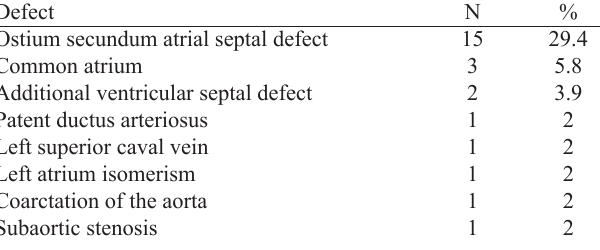
Table 2. Associated minor heart defects* noted before